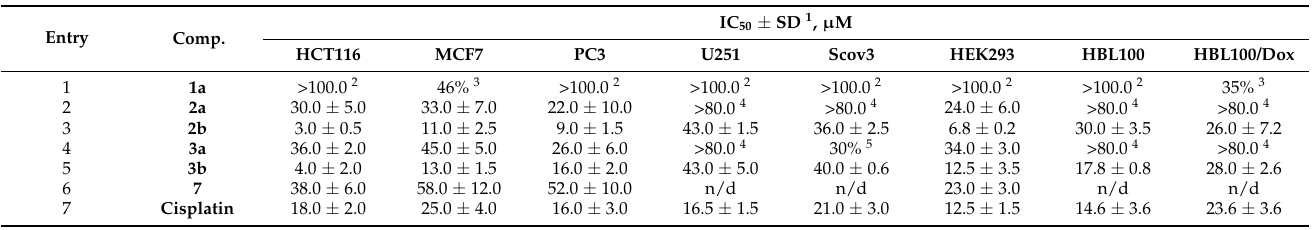
Table 2. Cytotoxicity of the phosphoryl-functionalized amide derivatives against some human solid cancer and non-cancerous cell lines.